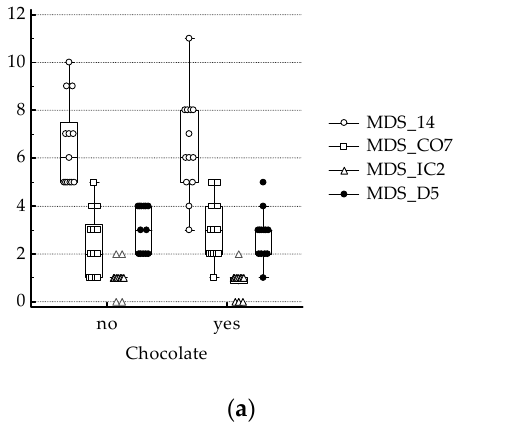
Figure 1. Adherence to Mediterranean diet ( a ) MDS 14 and sub-scores: coherent (CO7), incoherent (IC2) and different (D5); description of what is contained in the first panel; ( b ) Score 55 and sub-scores: coherent (CO30), incoherent (IC10) and different (D15). No significant differences between chocolate consumers and non- consumers.